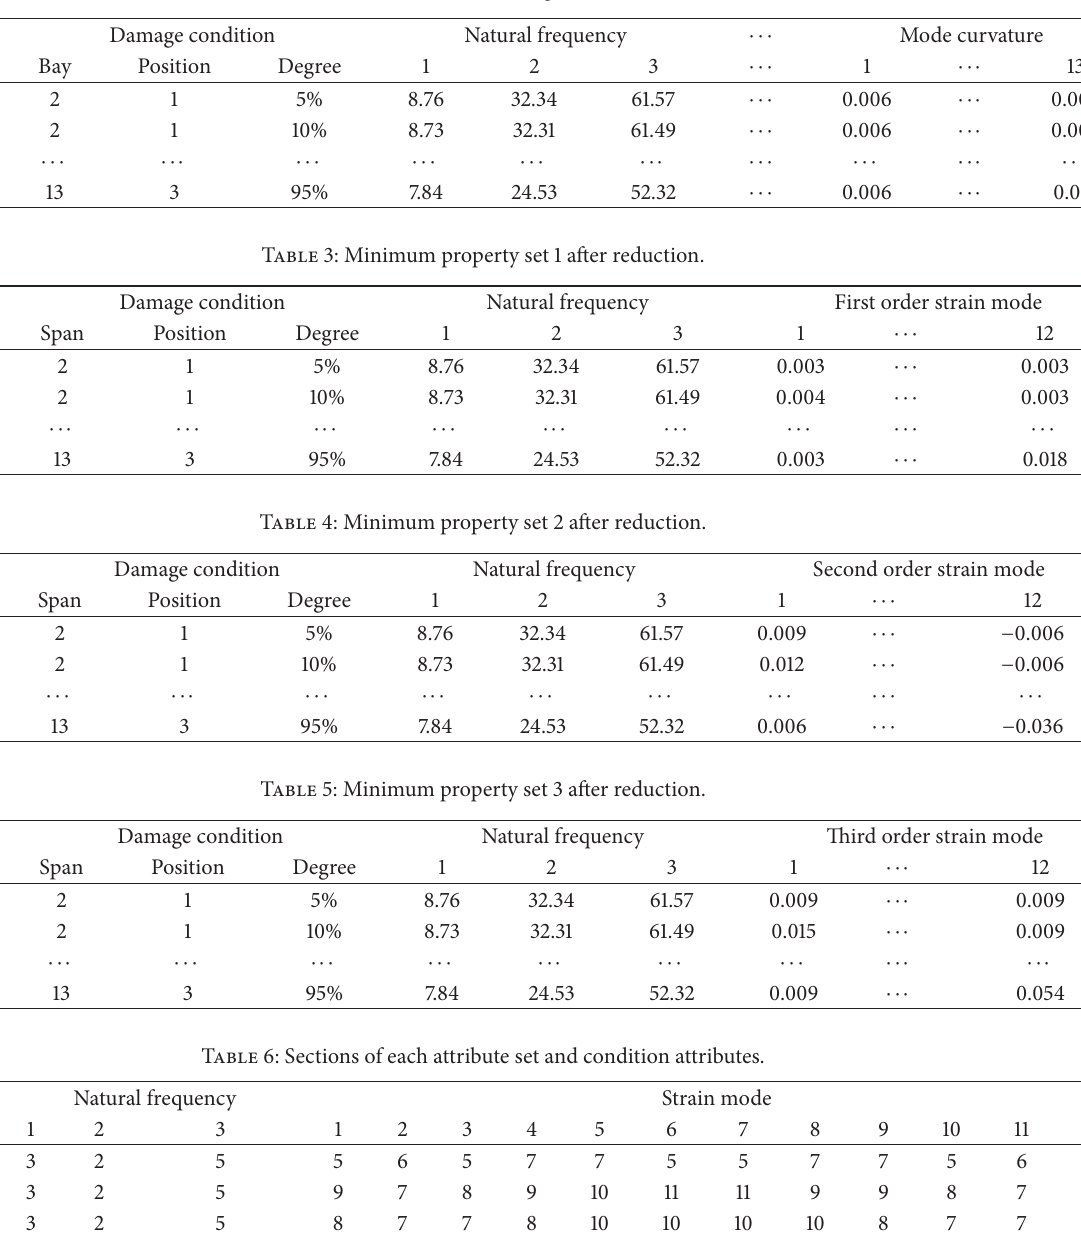
Table 2: Structural damage database.